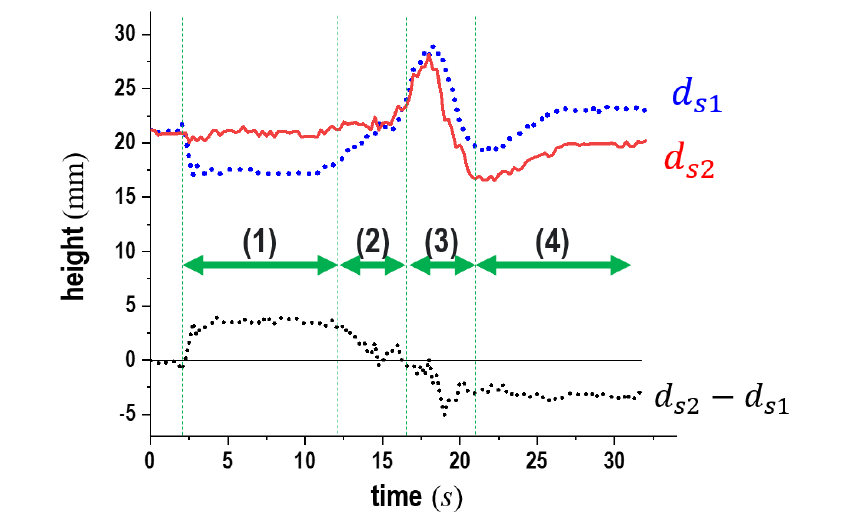
Figure 23. Measurement results of d s 1 and d s 2 by sensor #1 and sensor #2.